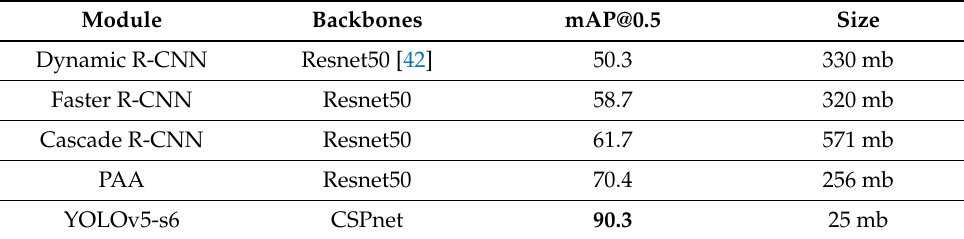
Table 4. Comparison of different models on the SARS-CoV-2 fluorescent RNA dataset.